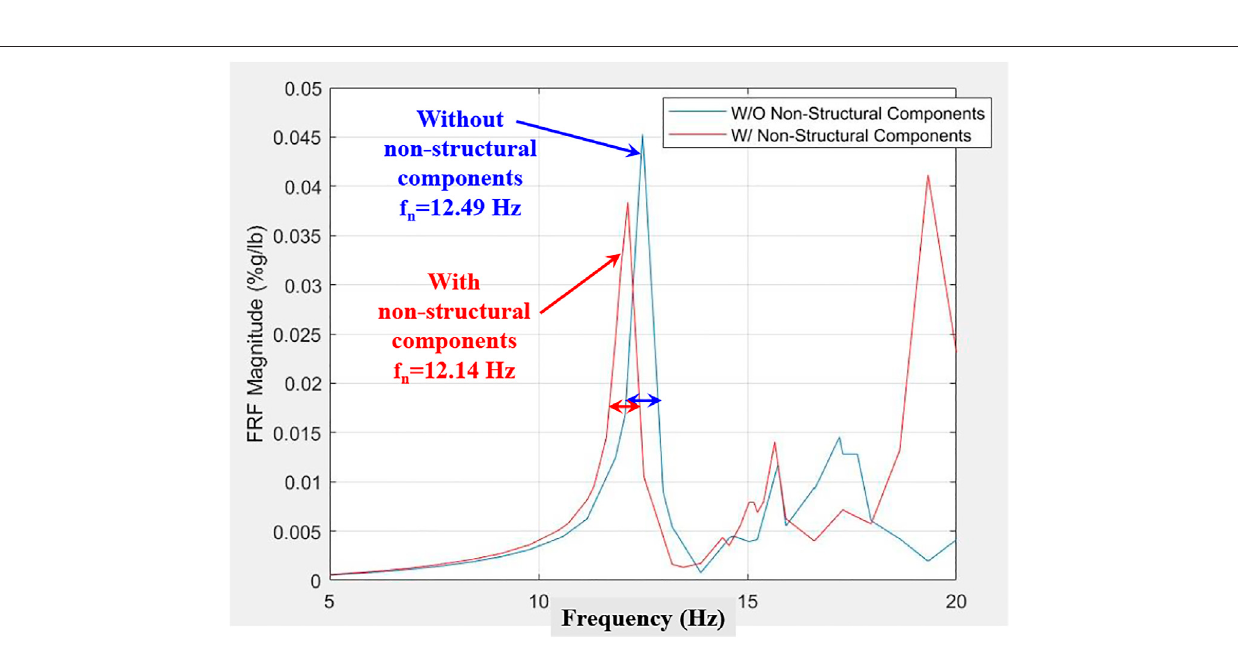
Frontiers in Built Environment |